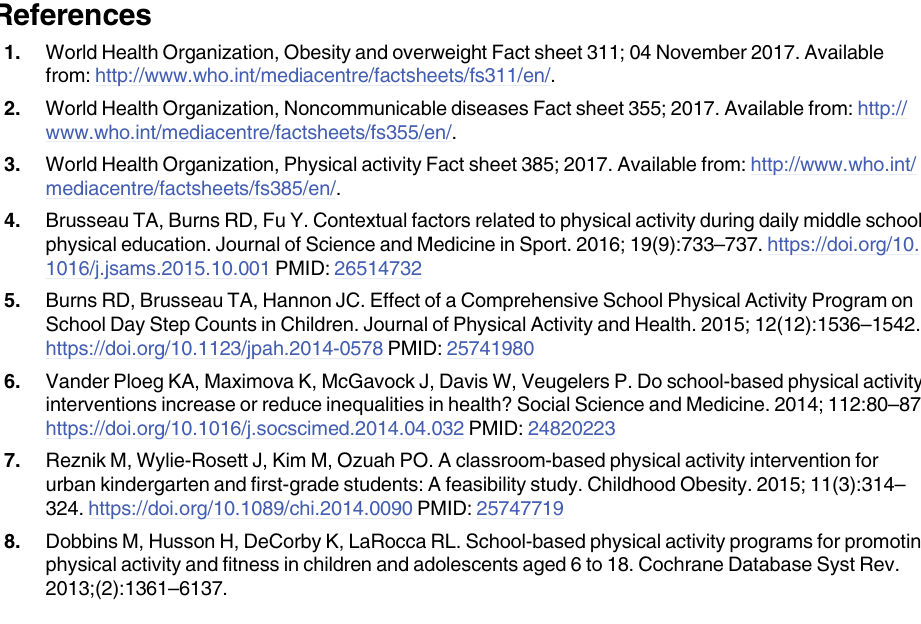
S1 Table. Characteristics of studies. S2 Table. Summarized